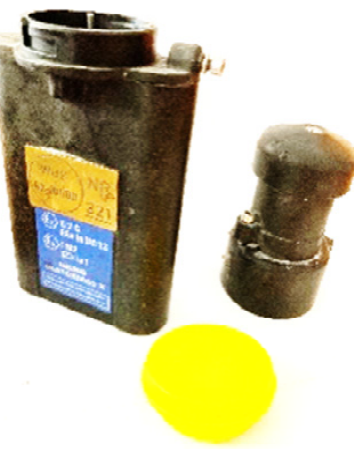
Figure 4. CIP-10R personal dust meter for measuring the PM4 dust respirable fraction of. Measurements with the use of CIP-10R dust meters enabled calculating the average dust concentration at the given measuring points (1).